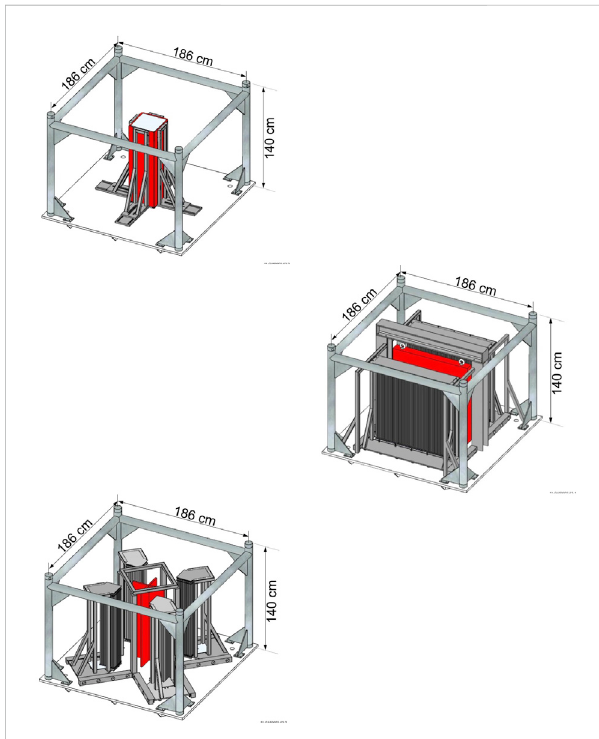
Con fi gurationsofscreensinMIRTEexperiments:Re fl ected(Top), interacting with Thick screen (middle), and interacting with Thin cruciform screens